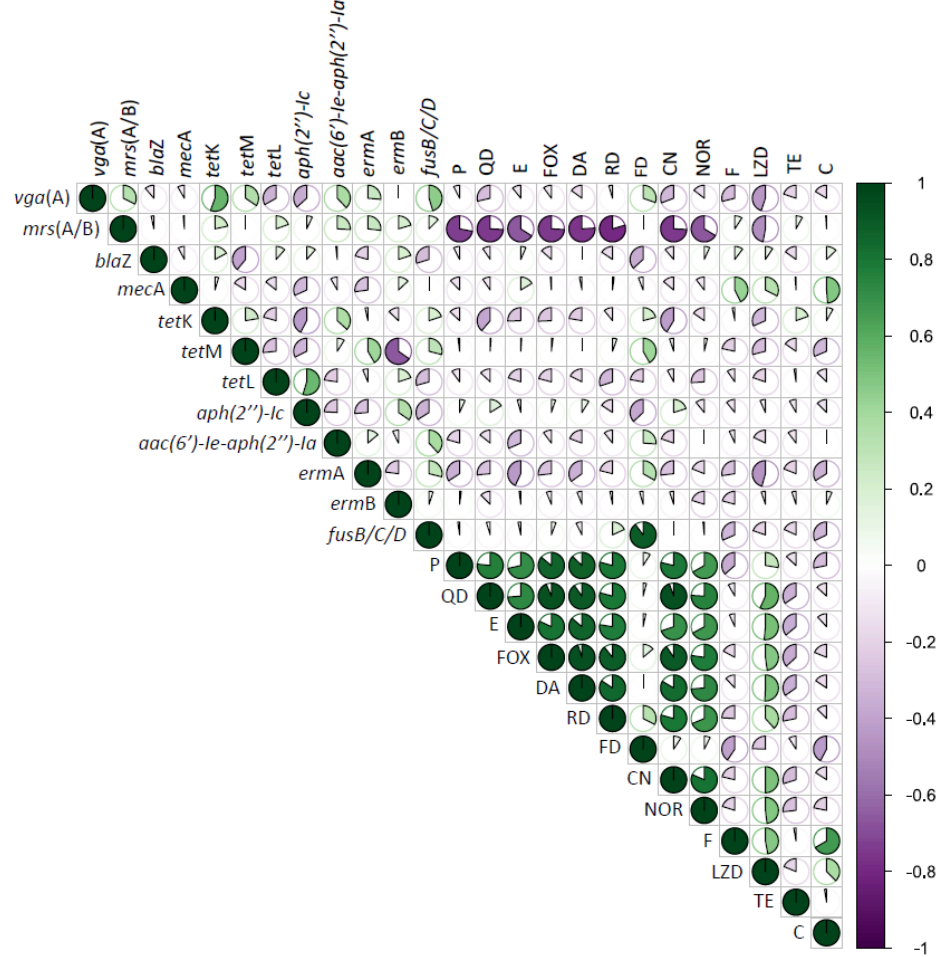
Figure 2. Correlation matrix of genotypic and phenotypic antibiotic resistance of all ( n = 85) CoNS isolates. Green is positive correlation and purple is negative correlation. The strength of the color and size indicate the numerical value of correlation coefficient. Abbreviations: P—penicillin, QD— quinupristin/dalfopristin, E—erythromycin, FOX—cefoxitin, DA—clindamycin, RD—rifampicin,